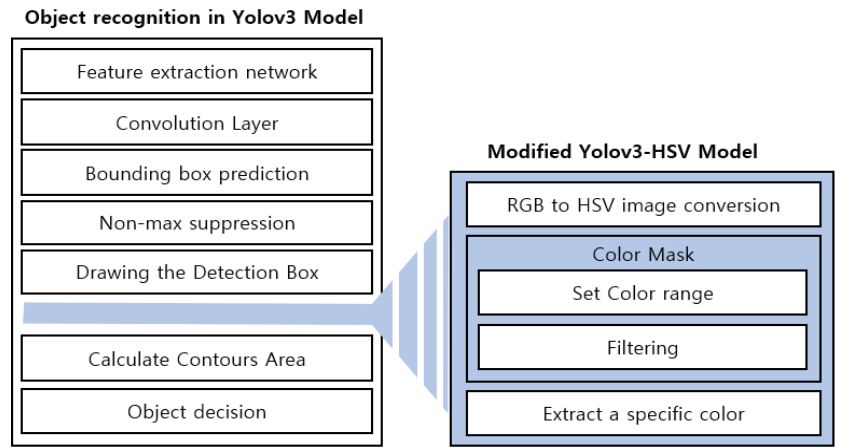
Figure 8. Model structure modified from Yolov3 to Yolov3-HSV [22].